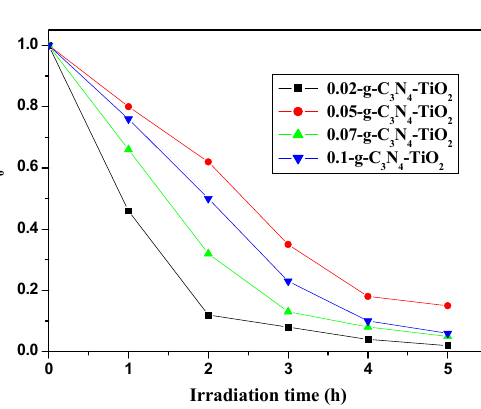
Figure 6. Temporal curves of the photodegradation of BDE209 with x -g-C 3 N 4 -TiO 2 ( x = 0.02 to 0.1) under visible irradiation. BDE209: 1.0 × 10 − 5 mol/L; g-C 3 N 4 -TiO 2 : 1 mg/mL; solvent: CH 3 OH; wavelength >420 nm; anoxic condition.